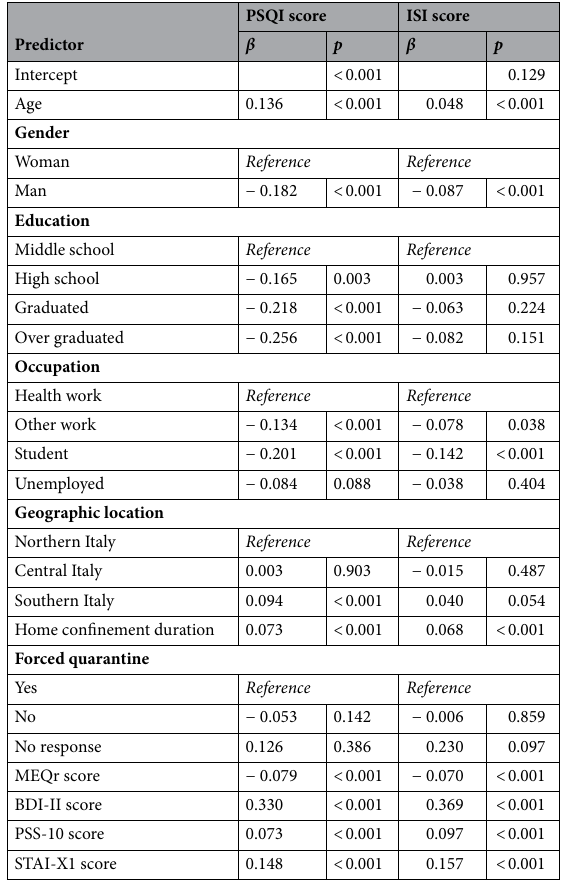
Table 2. Results ( β and p ) of the multiple linear regressions on PSQI and ISI scores. MEQr Morningness- Eveningness Questionnaire-reduced, BDI-II Beck Depression Inventory-second edition, PSS-10 Perceived Stress Scale-10 item, STAI-X1 state-anxiety subscale of the State-Trait Anxiety Inventory. a Northern Italy: Aosta Valley, Emilia Romagna, Friuli-Venezia Giulia, Liguria, Lombardy, Piedmont, Trentino-Alto Adige, and Veneto. b Central Italy: Lazio, Marche, Tuscany, and Umbria. c Southern Italy: Abruzzo, Apulia, Basilicata, Calabria, Campania, Molise, Sardinia, and